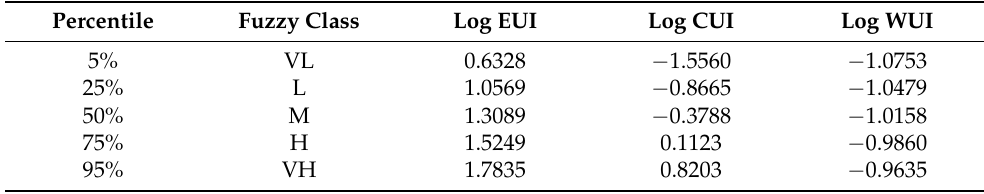
Table 2. Fuzzy classes and their corresponding percentiles.